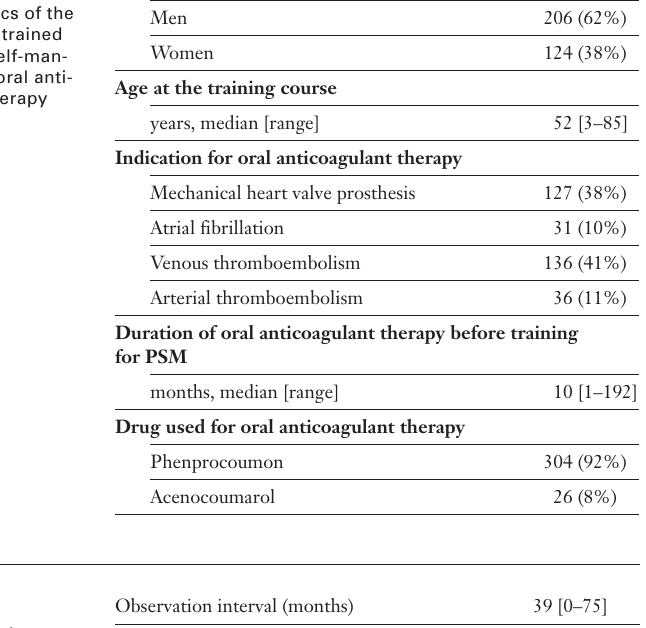
Analysis of adverse events among the 300 patients with the respective infor- mation available.